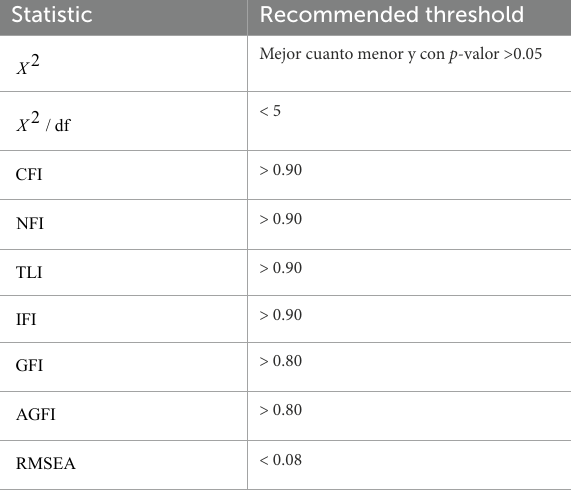
TABLE 2 Thresholds for model